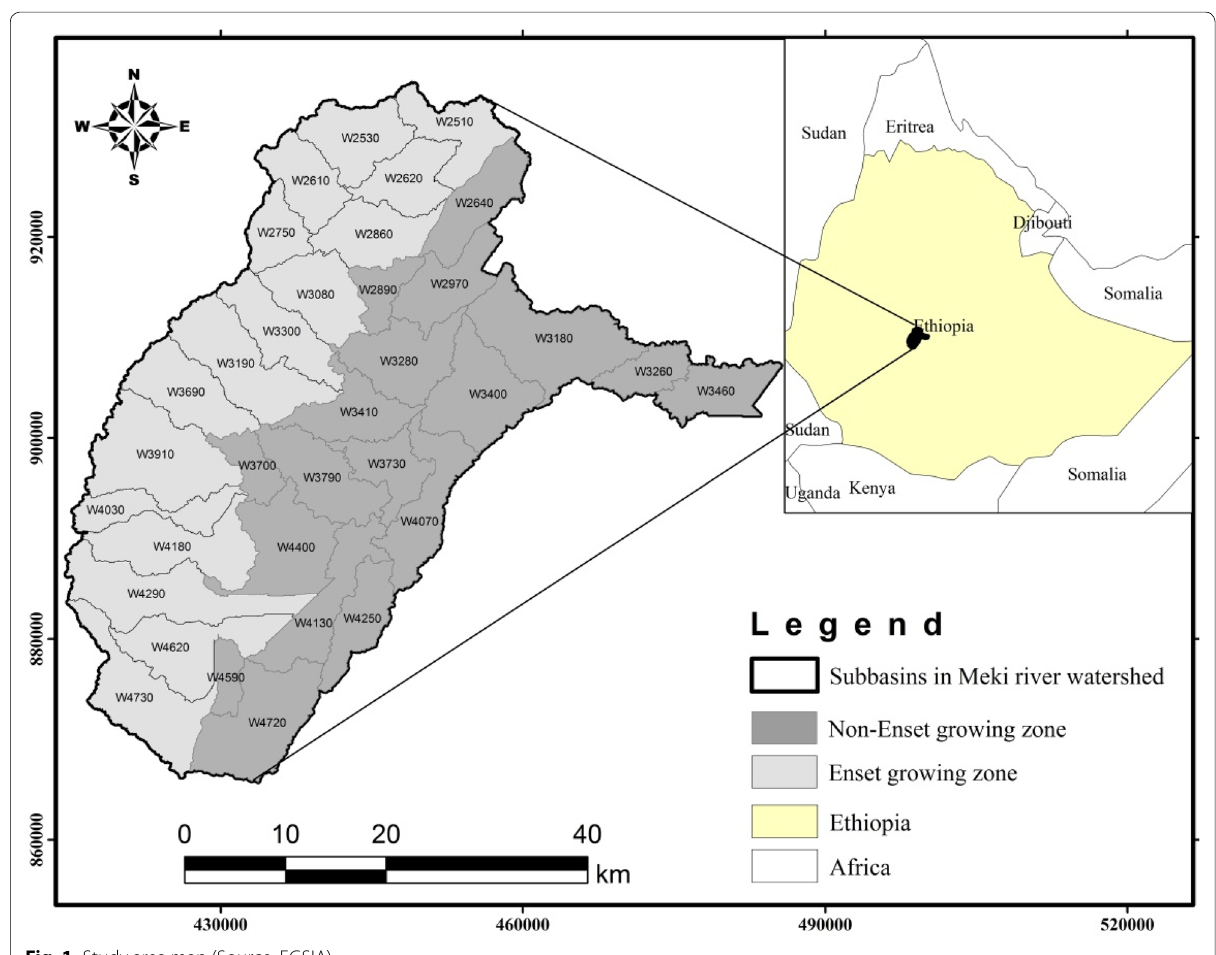
Fig. 1 Study area map (Source: